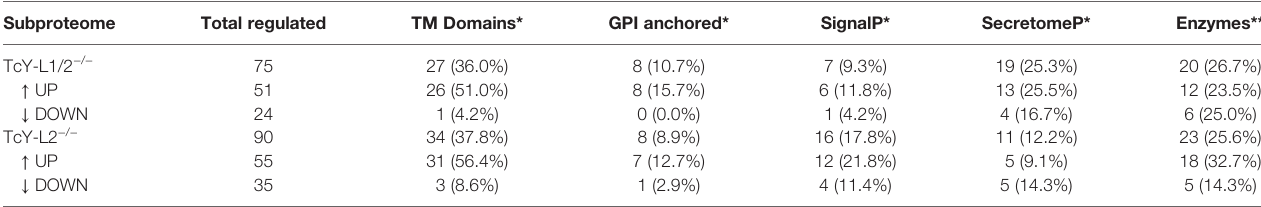
TABLE 1 | Number of proteins from the regulated subproteome with predicted transmembrane domains, GPI-anchor, classically and non-classically secreted, and enzymes. Subproteome